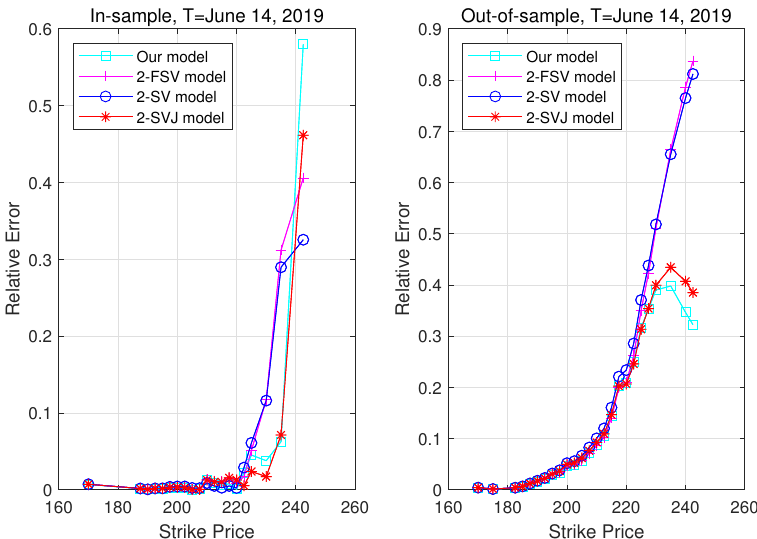
Figure 4. The comparison of predicted prices of four model specifications and market prices on 9 May 2019, with maturity T = 14 June 2019.